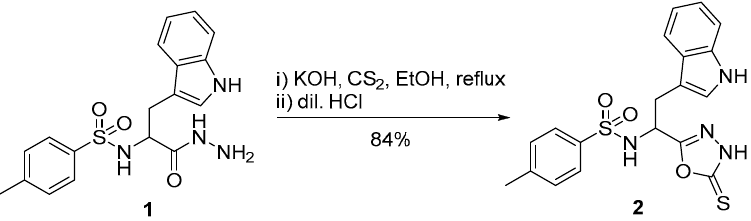
Scheme 1. Synthesis of N -[2-(1 H -indol-3-yl)-1-(5-thioxo-4,5-dihydro-1,3,4-oxadiazol-2-yl)ethyl]-4 -methylbenzenesulfonamide ( 2 ).